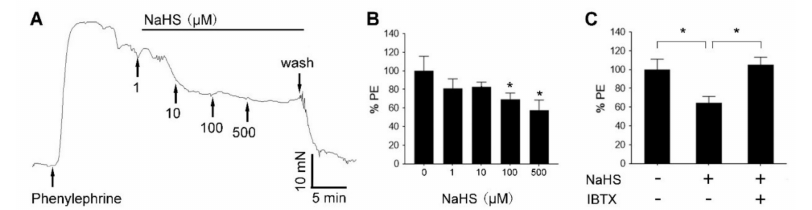
Figure 6. BK Ca in H 2 S-induced relaxation of human uterine artery in vitro. ( A ) Freshly prepared human main uterine artery (UA) rings were preconstricted with phenylephrine (PE, 10 µ M) in organ bath to achieve steady contraction for at least 5 min. Increasing concentrations (1, 10, 100, and 500 µ M) of NaHS was then applied sequentially to relax the preconstricted UA ring. A representative dose–response curve of H 2 S-induced UA relaxation was shown to represent similar results of three UA ring preparations from three patients. ( B ) Bar graph summarizing the e ff ects of NaHS on human UA (hUA) relaxation. NaHS at 100 and 500 µ M decreased the artery tension to 69.3 ± 6.6% and 57.6 ± 10.8% of the maximum contraction of PE. * p < 0.05 compared with NaHS at 0. ( C ) NaHS (100 µ M) decreased artery tension to 64.6 ± 6.7% of the maxi contraction induced by PE, and the NaHS-induced UA relaxation was reversed by co-incubation with the BK Ca channel blocker iberiotoxin (IBTX, 100 nM). * p <